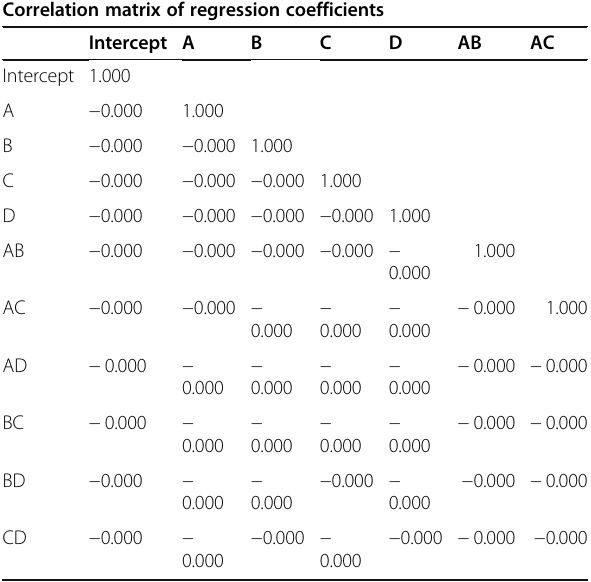
Table 6 Correlation matrix of regression coefficients Correlation matrix of regression coefficients